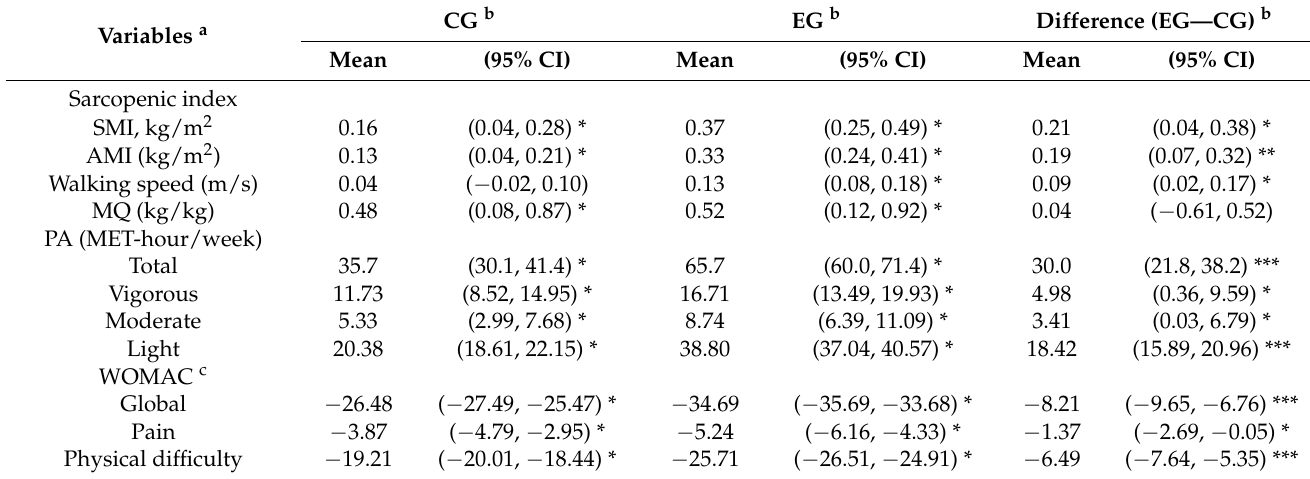
Table 3. Mean changes in primary outcome measures at posttest.